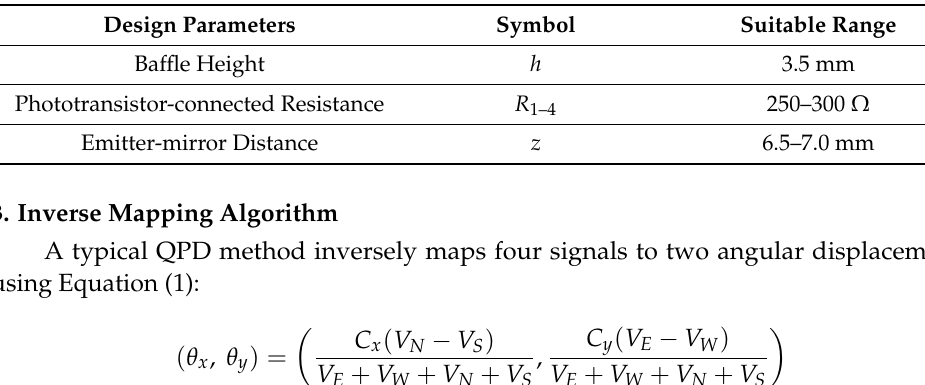
Table 2. The most suitable ranges for the design parameters.